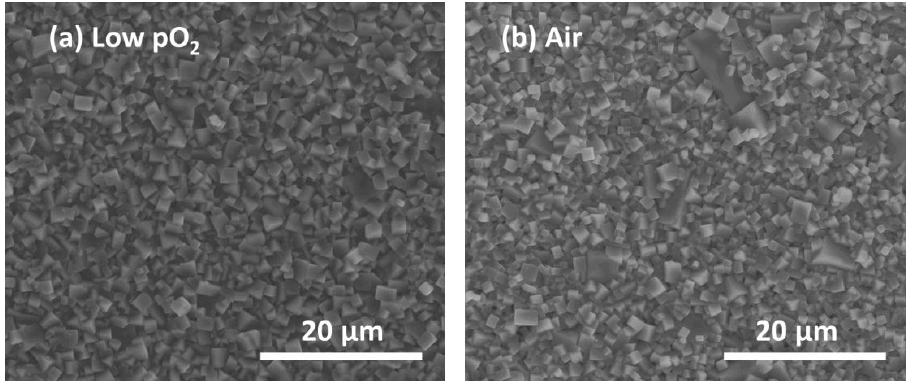
Figure 9. Surface micrograph of ( a ) low pO 2 –sintered and ( b ) air-sintered pellets at 1050 °C for 1 h.